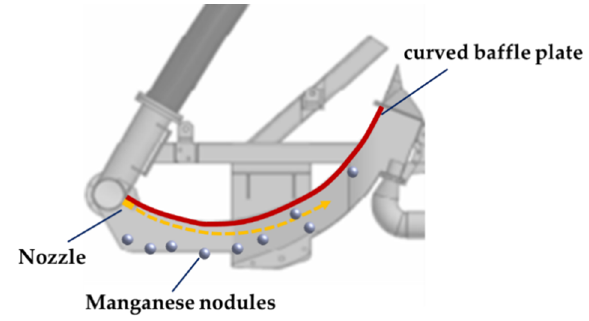
Figure 2. Coandă effect-based hydraulic-type collector head [6]. Figure 2. Coand ă effect-based hydraulic-type collector head [6].